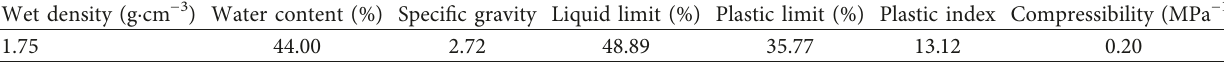
Table 1: Basic physical properties of the Bayer process red